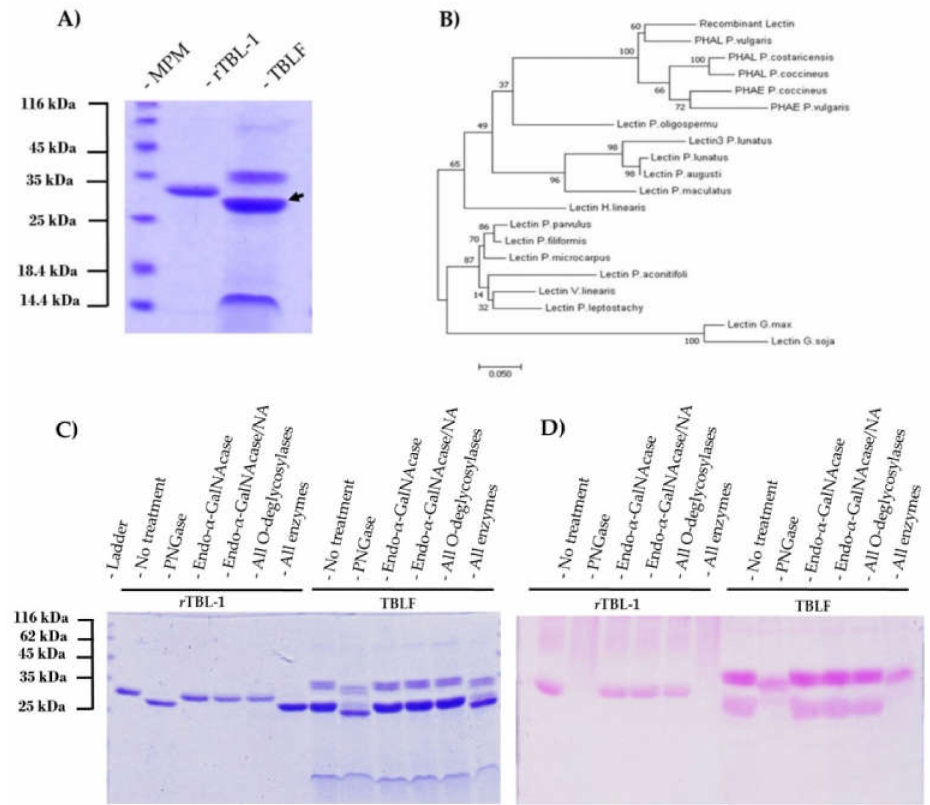
Figure 3. MolecularcomparisonofrecombinantandnativeTBL-1: ( A )SDS-PAGEelectrophoresisof r TBL-1 and Tepary Bean Lectin Fraction (TBLF) (gels stained for total protein). The black arrow shows native TBL-1. ( B ) Comparative phylogenetic sequence analysis of several legume lectins. ( C ) SDS-PAGE of r TBL-1 and Tepary bean lectin fraction (TBLF) +/ − deglycosylation treatments. Lane 1, r TBL-1 no enzyme control; lanes 2–5, r TBL-1 treated with PNGaseF, endo- α -GalNAcase, endo- α -GalNAcase, and neuraminidase (NA), respectively; lane 6, r TBL-1 treated with all O -deglycosylases ( β 1,4-galactosidase, endo- α -GalNAcase, NA, and β -N-acetylglucosaminidase); lane 7, r TBL-1 treated with all deglycosylases ( N -glycosidase F, β 1,4-galactosidase, endo- α -GalNAcase, NA, and β - N -acetylglucosaminidase); lane 8, TBLF without treatment; lanes 9–11 TBLF treated with PNGaseF, endo- α -GalNAcase, endo- α -GalNAcase, and NA, respectively; lane 12, TBLF treated with all O-desglycosylases ( β 1,4-galactosidase, endo- α -GlcNAcase, NA, and β - N -acetylglucosaminidase); lane 13, TBLF treated with all deglycosylases ( N -glycosidase-F, β 1,4-galactosidase, endo- α -GalNAcase, NA, and β - N -Acetylglucosaminidase). ( D ) SDS-PAGE of r TBL-1 and TBLF +/ – deglycosylation treatments stained with Schiff-PAS reagent for the detection of